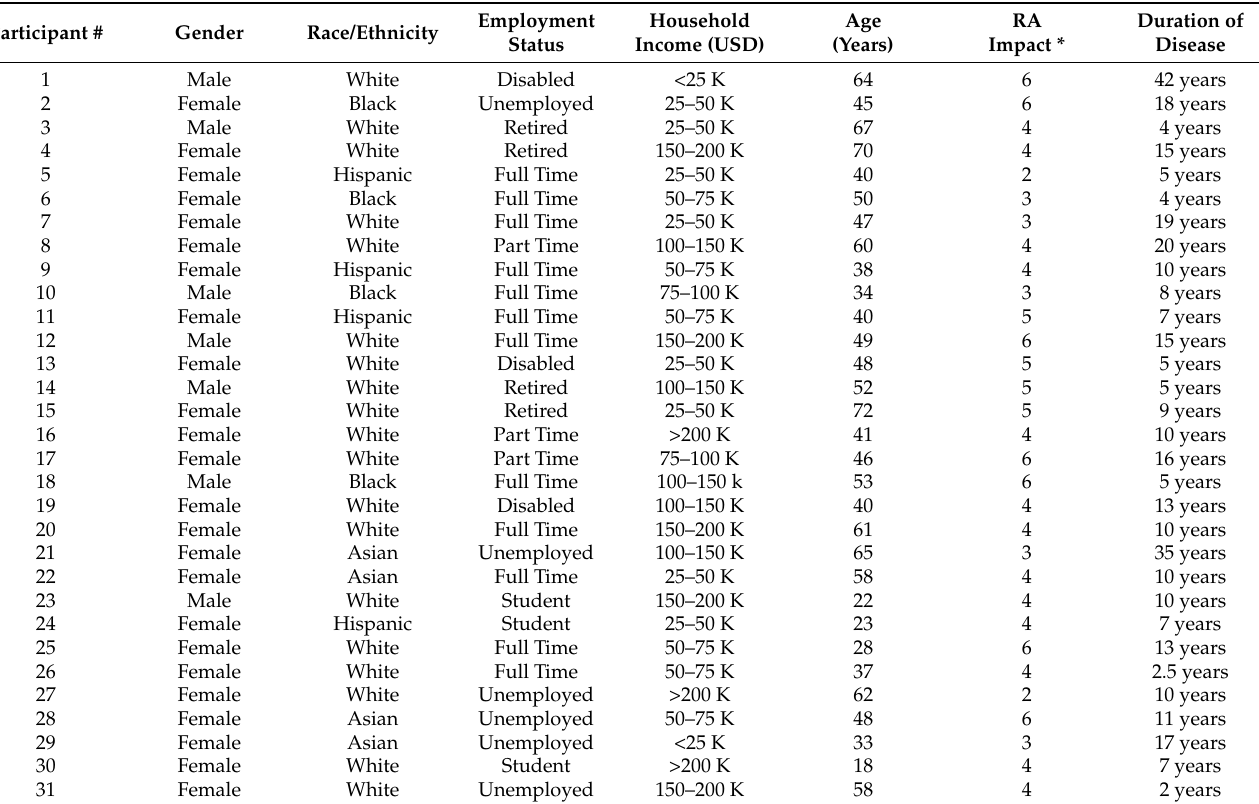
Table 1. Participant self-reported demographic and disease-related